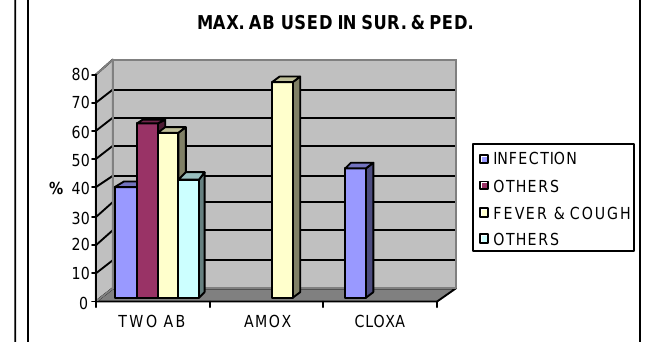
Fig. 4b : Showing antibiotics used in OPD of